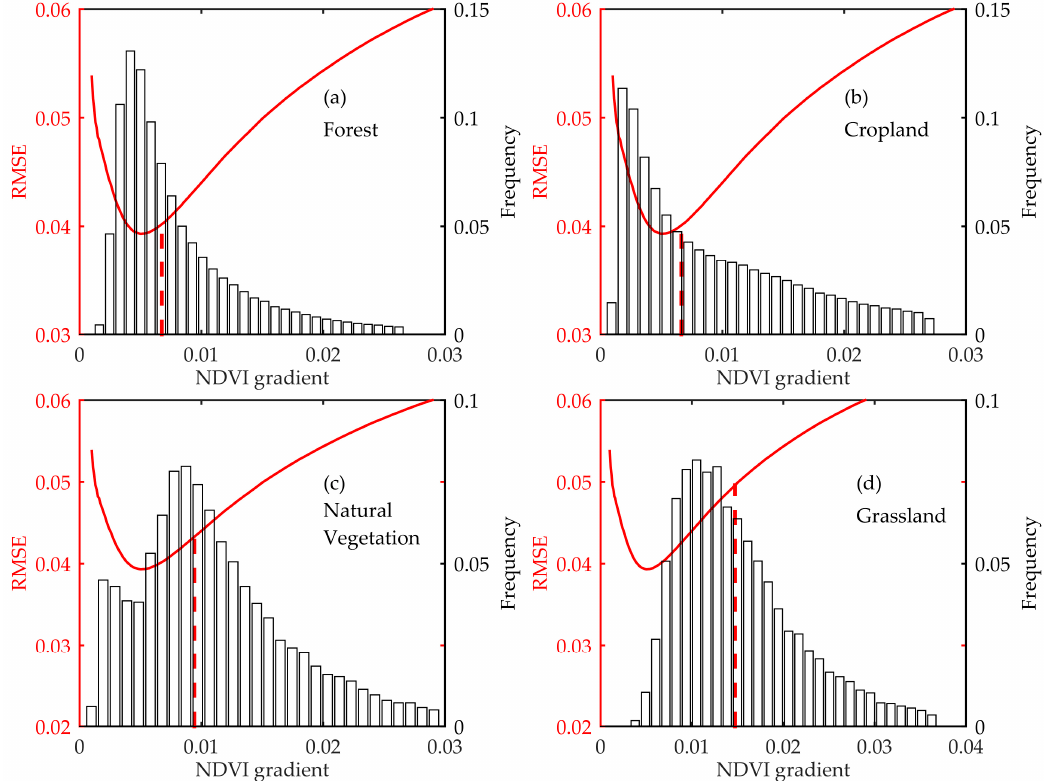
Figure 12. Frequencies of NDVI gradients for different vegetation types and its relationship with RMSE produced by the NP algorithm in the research area (the red curve). The red dashed line represents the median of the histogram in each graph. ( a ) Forest; ( b ) Cropland; ( c ) Natural vegetation; ( d ) Grassland. Table 6. Medians of NDVI gradients and algorithm accuracy for different vegetation types.